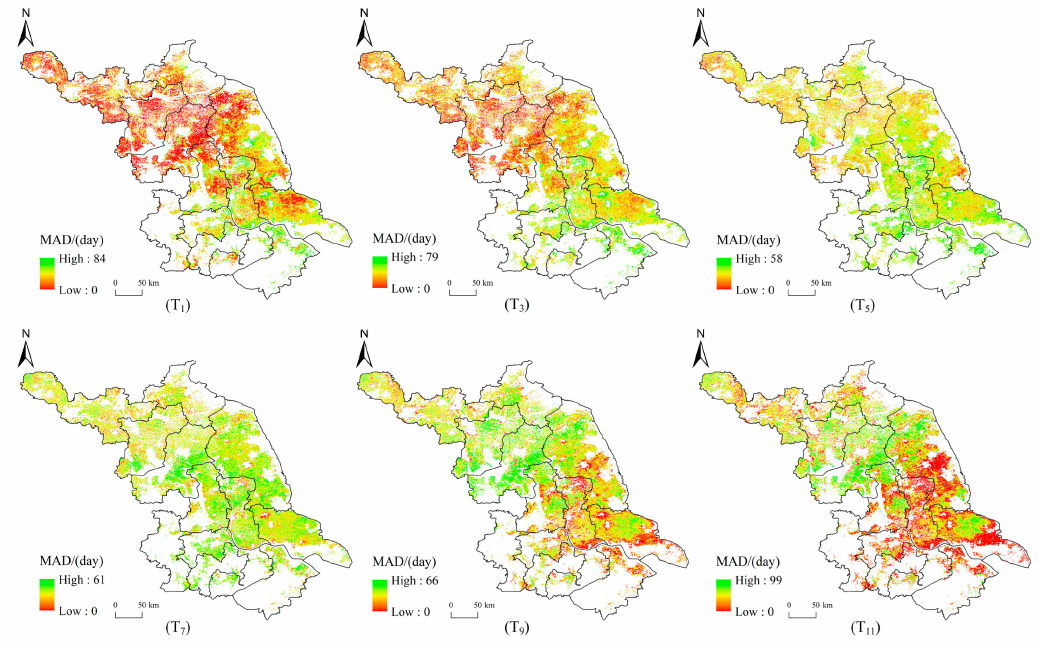
Figure 10. Spatial distribution of the second crop MAD during a double season. Partial results (T 1 , T 3 , T 5 , T 7 , T 9 , and T 11 ) are shown. T 1 : 2001–2007; T 2 : 2002–2008; T 3 : 2003–2009; ... ; T 11 :